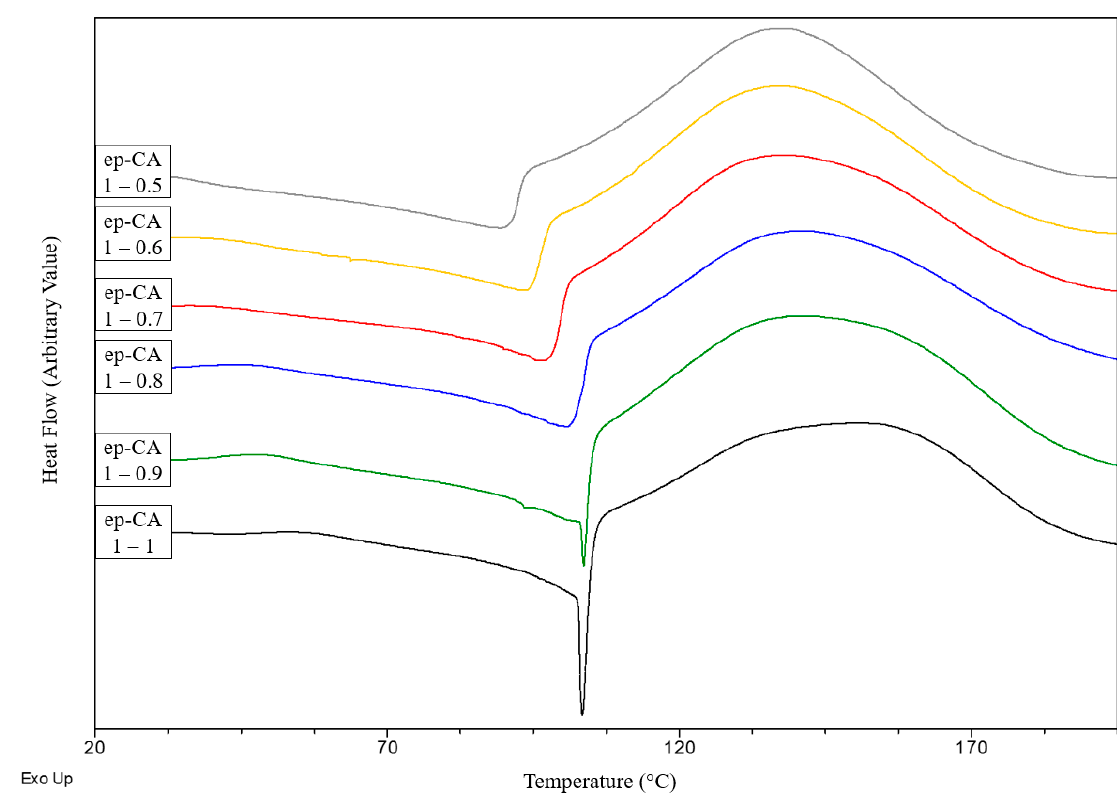
Figure 1. Thermograms of dynamic curing reaction of thermoset series with varying Epoxide function/CA ratios.